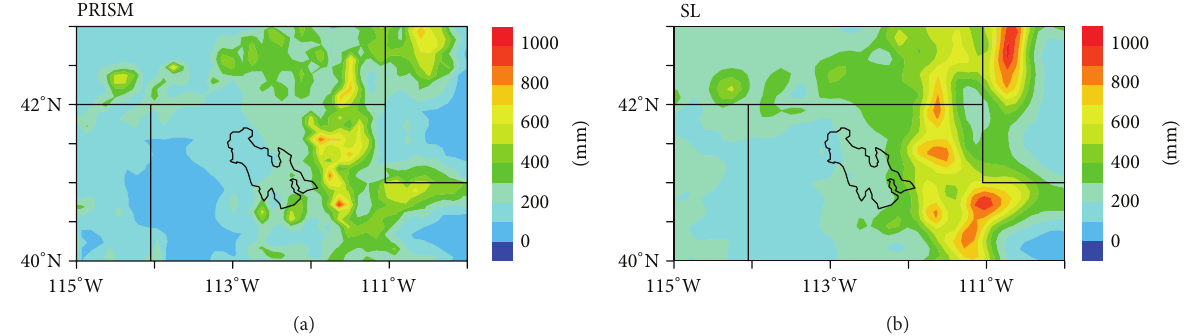
Figure 3: PRISM precipitation and simulated precipitation in SL experiment from October 2001 to April